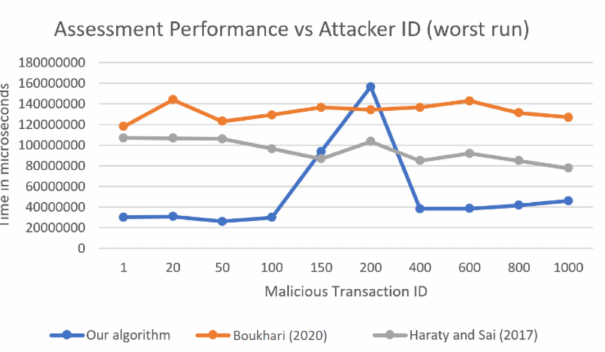
Figure 4. Comparison of the worst times of three algorithms as a function of the malicious transac- tion